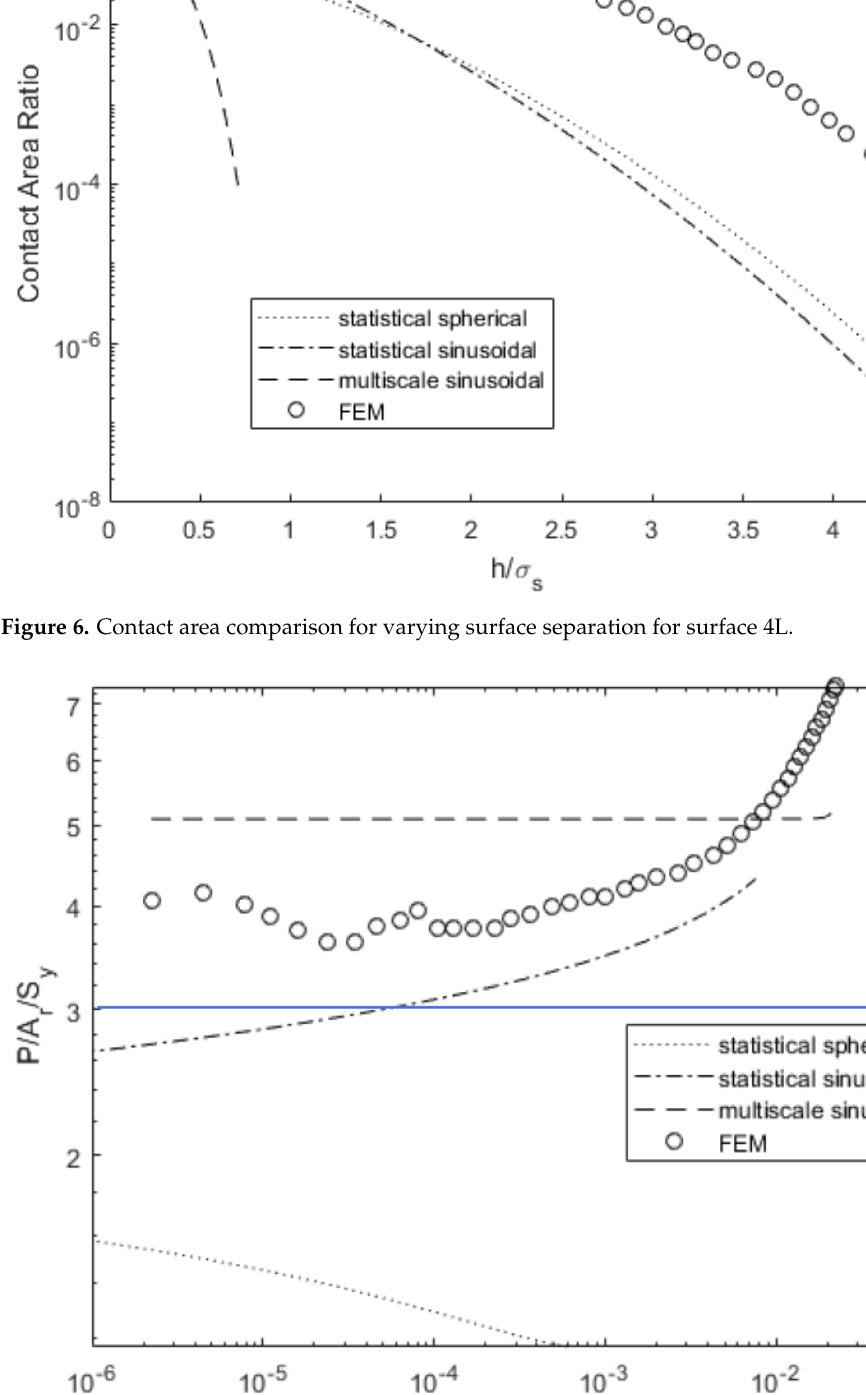
Figure 8. Load-dependent contact area variation for surface 4L.